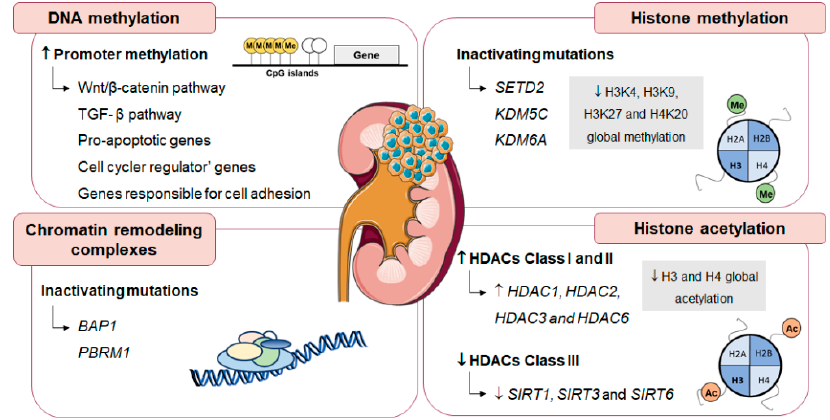
Figure 4. Epigenetic signature of RCC. Aberrant DNA methylation, chromatin remodeling complexes, and histone post-translational modifications regulate gene transcription and DNA stability through alterations in chromatin structure, contributing to RCC tumorigenesis and aggressiveness.